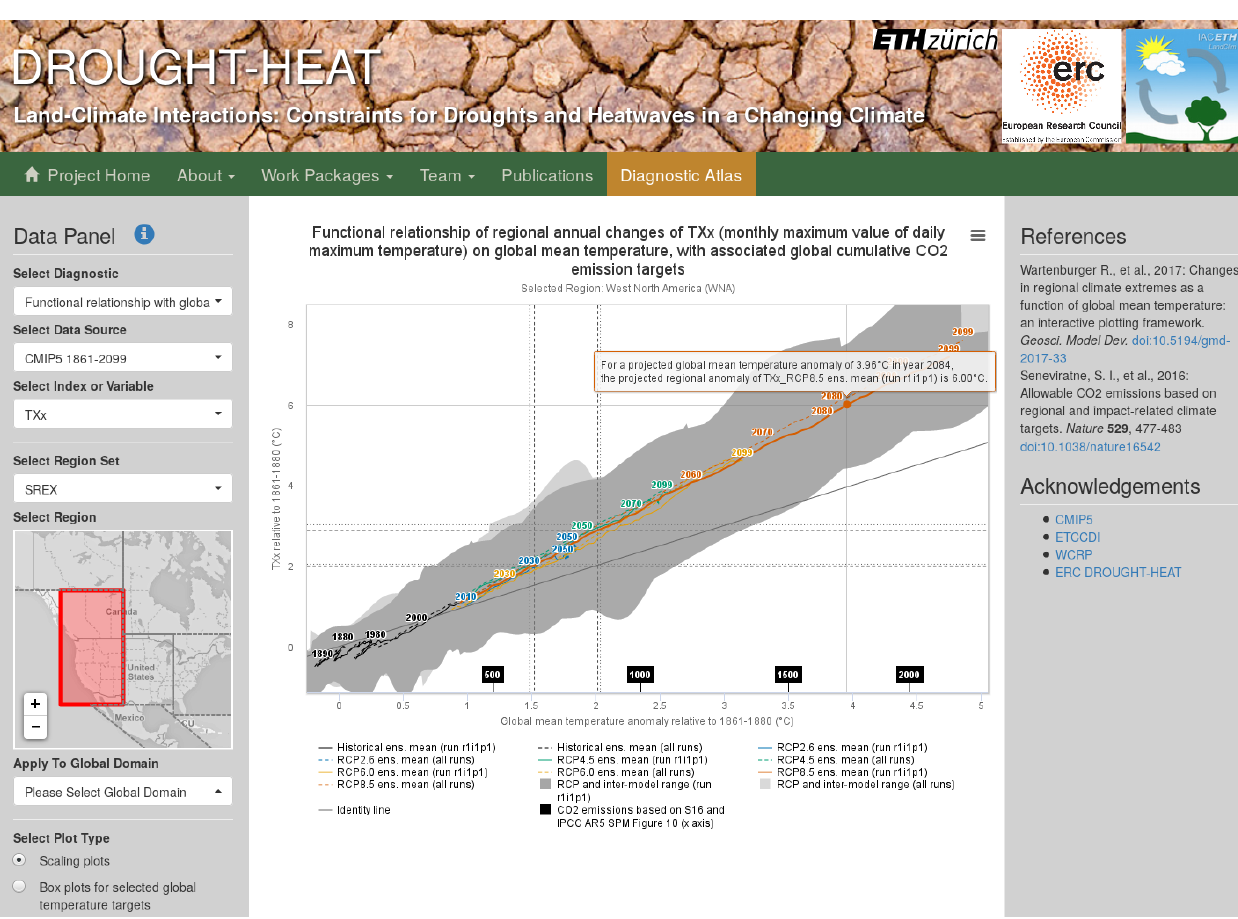
Figure 2. Screenshot of the DROUGHT-HEAT Regional Climate Atlas. For demonstration, this screenshot displays the functional relation- ship of (cid:49)T Xx on (cid:49)T glob based on model simulations from 1861 to 2099 for the SREX region west North America